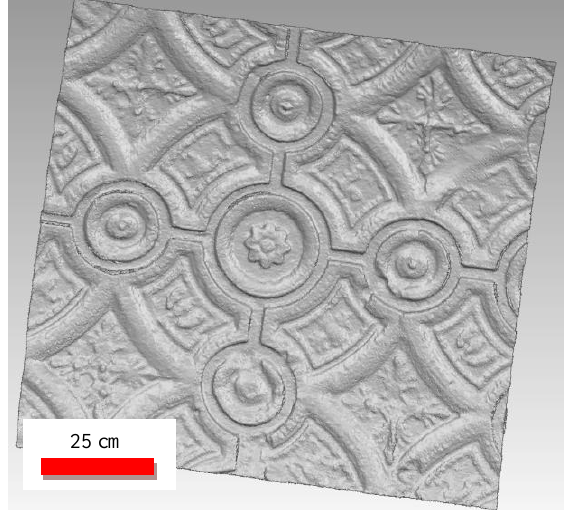
Figure 11. A detail of the surface model – Room 1